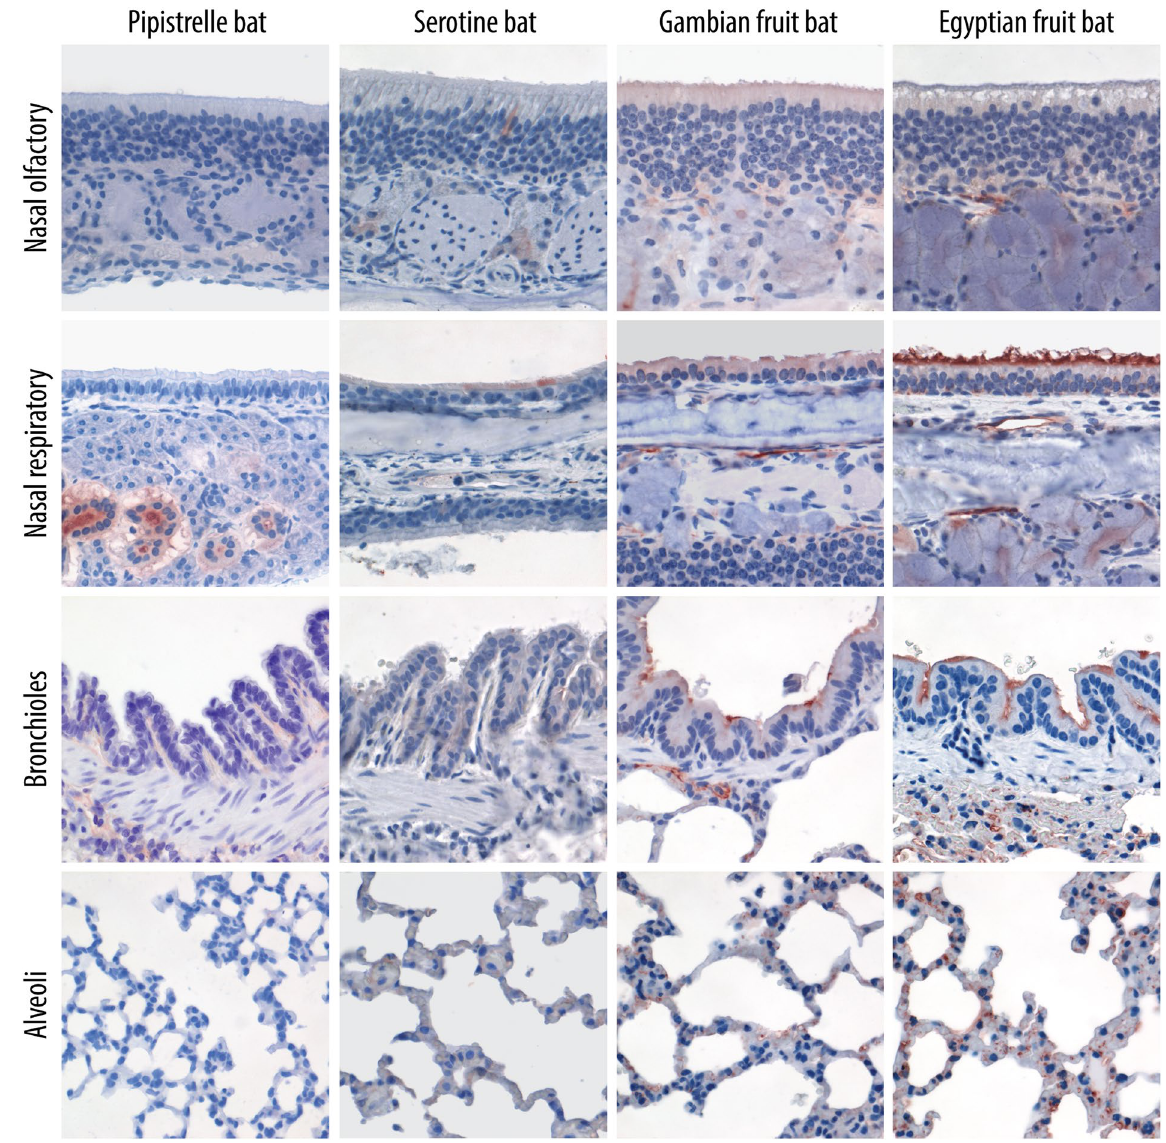
Figure 1. DPP4 expression in the respiratory tract tissues of common pipistrelle bat, serotine bat, Gambian epauletted fruit bat, and Egyptian fruit bat. DPP4 (indicated in red) is expressed in the nasal, bronchiolar and alveolar epithelium of the fruit bats, with limited expression in the epithelium lining the nasal cavity of serotine bats, and not detected in the epithelium lining the respiratory tract of the common pipistrelle bats. Original magnification x400 for all